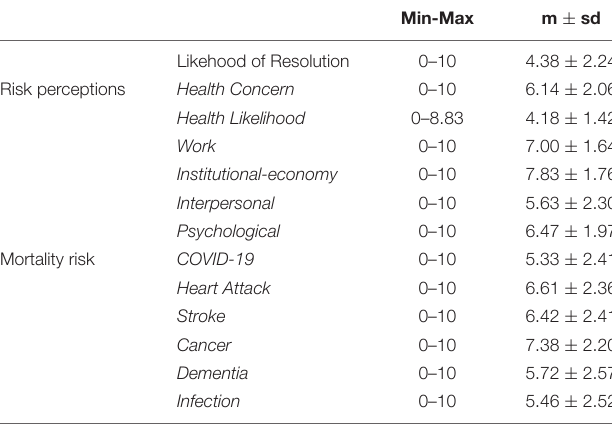
TABLE 3 | Descriptive statistics for risk perception